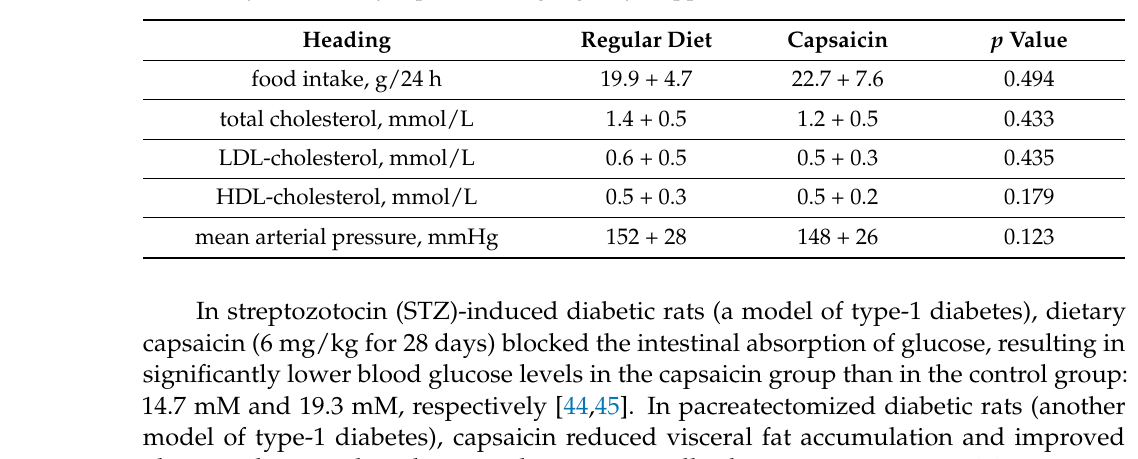
Table 2. Metabolic parameters and mean arterial blood pressure in rats on regular diet as determined after 14 days and dietary capsaicin (1 mg/kg/day) supplementation. Data are from